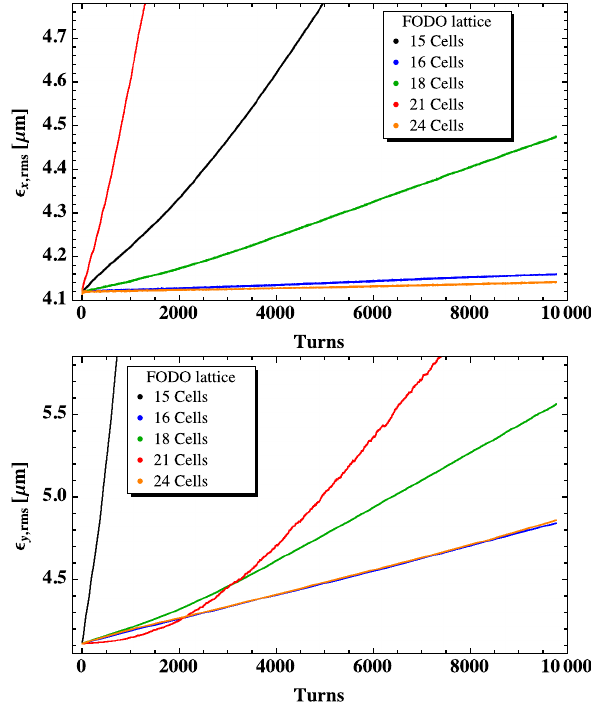
FIG. 13. Time evolution of horizontal (up) and vertical (bot- tom) rms emittance for a regular FODO lattice consisting of 15, 16, 18, 21 and 24 cells and onefold symmetry.